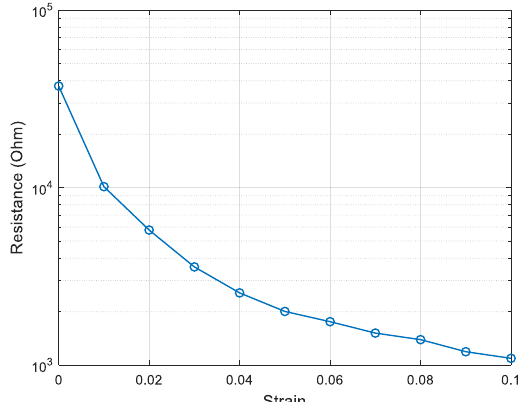
Figure 4. (a) Variation in AC admittance with extension for carbon fibre/silicone composites containing 15 vol% carbon fibre. (b) Variation in phase angle with extension for carbon fibre/silicone rubber composites containing 15 vol% carbon fibre.